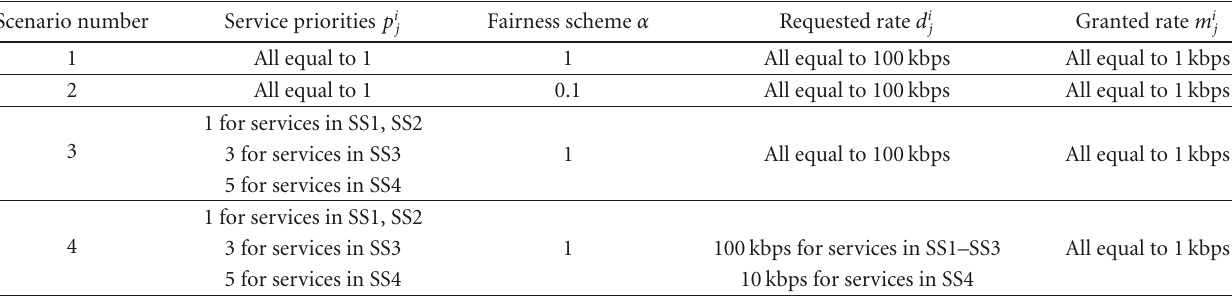
Table 1: Scenario